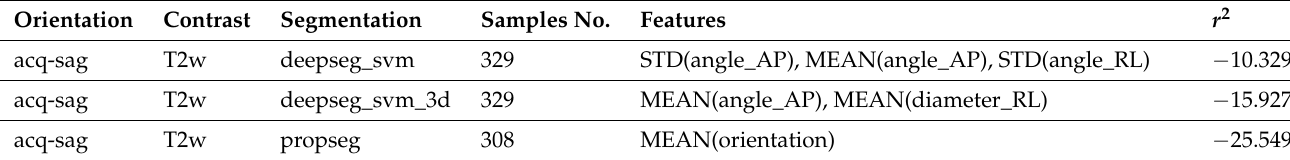
Table 5. The attributes of our linear models fit on metric data which was standardized to a common scale and harmonized by scanner used via CovBat. Orientation, contrast, and segmentation represent the acquisition methodology associated with the model. Features contains the list of features used to train the model, as selected by SciKit-Learn’s SelectFdr function.